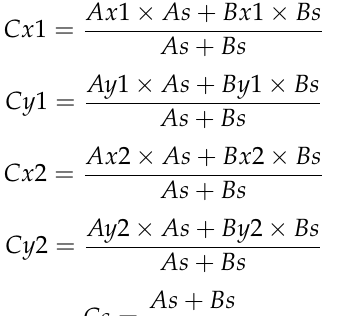
Figure 3. Process of two prediction boxes fusing into one box through the fusion box formula. The value calculated by Formulas (1) and (2) constitutes the upper-left coordinate of the 𝑏𝑏𝑜𝑥𝐶 fusion box; the value calculated by Formulas (3) and (4) constitutes the lower- right coordinate of the 𝑏𝑏𝑜𝑥𝐶 fusion box, and the confidence of the 𝑏𝑏𝑜𝑥𝐶 box is calcu- lated by Formula (5).